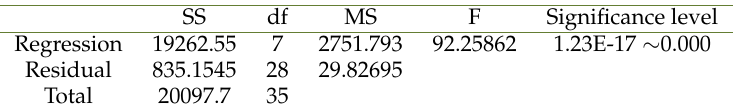
Table 5. Results of the